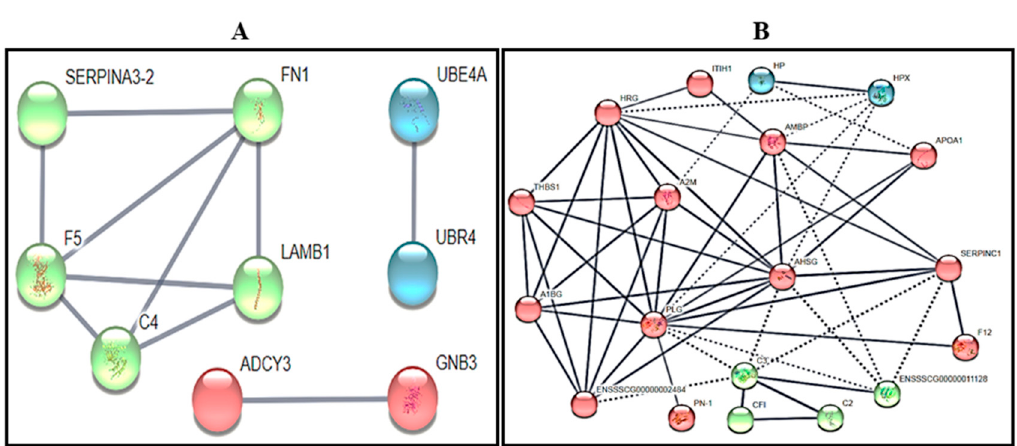
Figure 2. Protein-to-protein interaction networks of up-regulated proteins in small non-atretic (SNA: ( A )) and large non-atretic (LNA: ( B )) datasets.